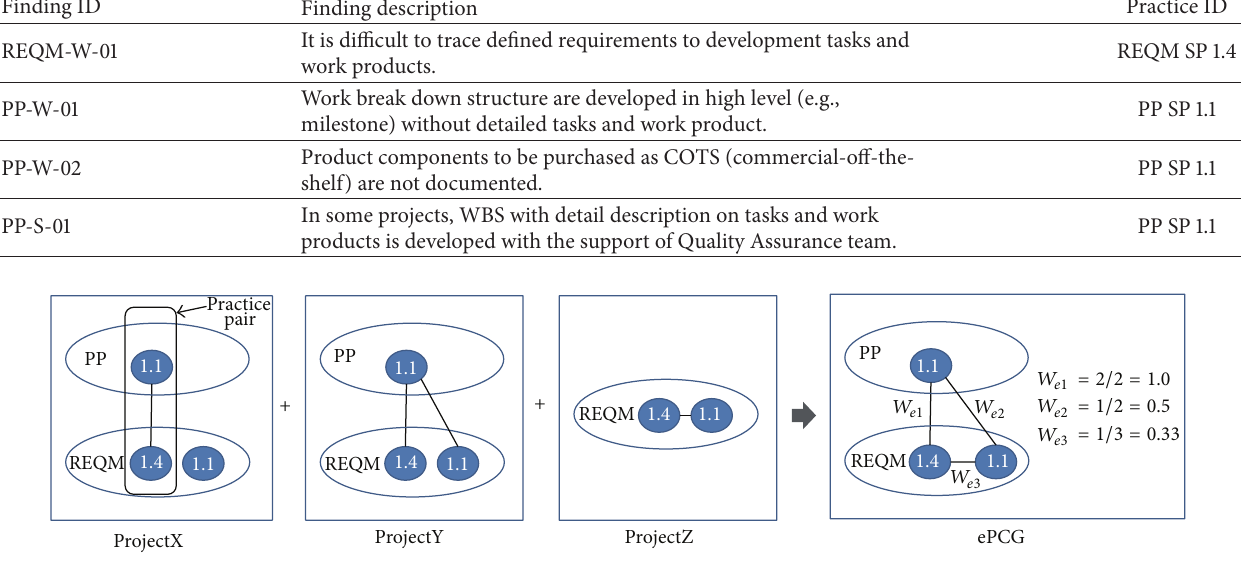
Figure 6: Building an